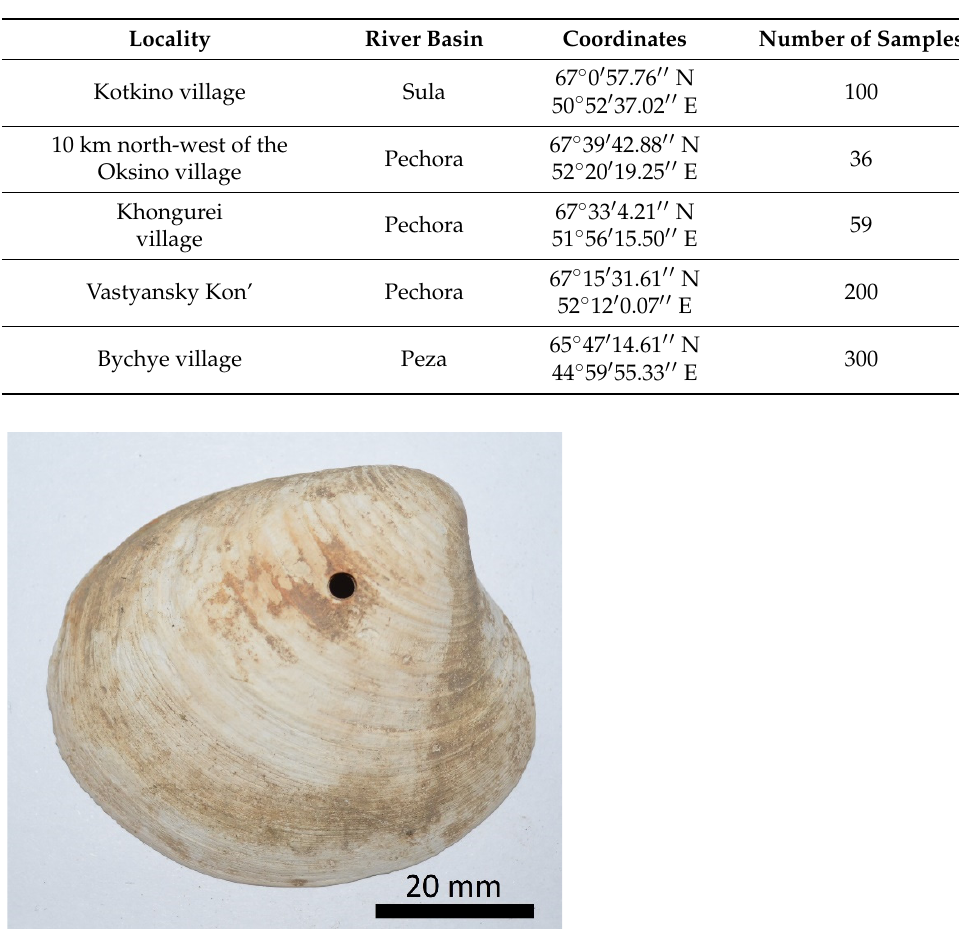
Table 1. Locality and River basin of fossil shells of the European North.